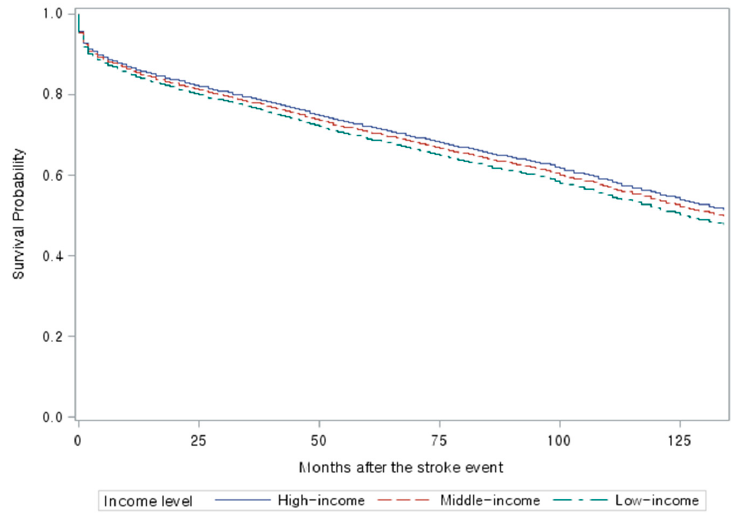
Figure 1. Multivariable adjusted survival Curves for Insured Employees by Income Level ( n = 7720;